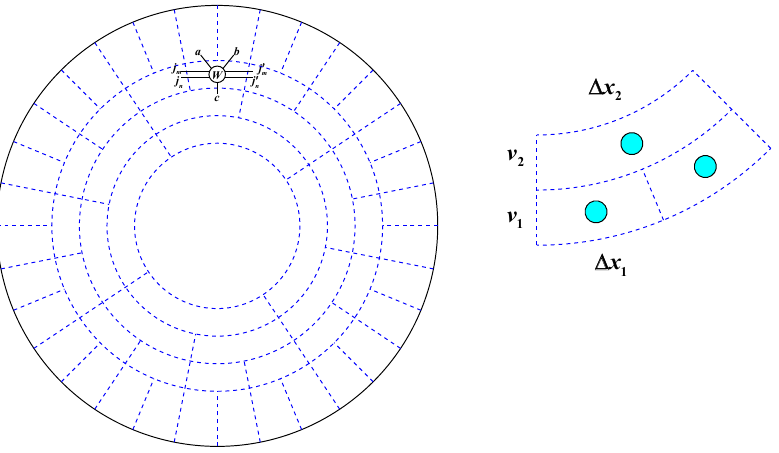
Figure 14 . (a) The MERA-like tensor network is a kind of discretization approximation of our surface growth picture. (b) Each euclideon e can be considered as a cell of bulk spacetime, i.e., the “source” in the “Huygens’